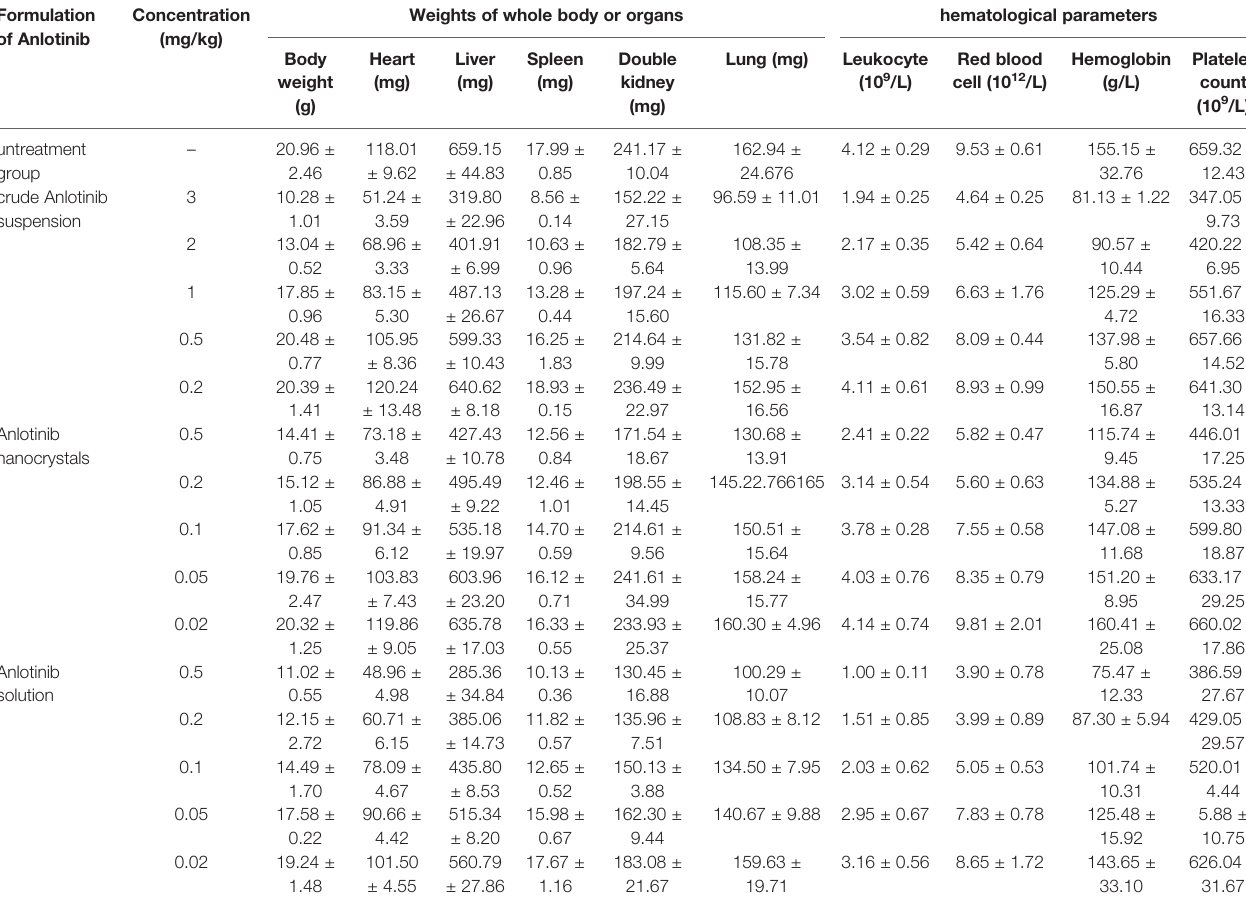
TABLE 1 | The side-effect of Anlotinib-formulations on nude mice ’ s body weights, organs mass or hematological parameters. Formulation of